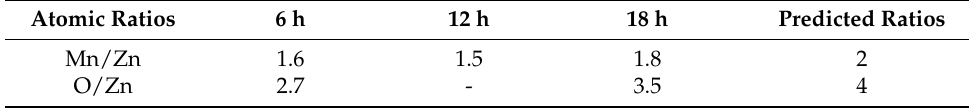
Table 4. Atomic ratios of Zn, Mn, and O in ZnMn 2 O 4 spinel samples. Atomic